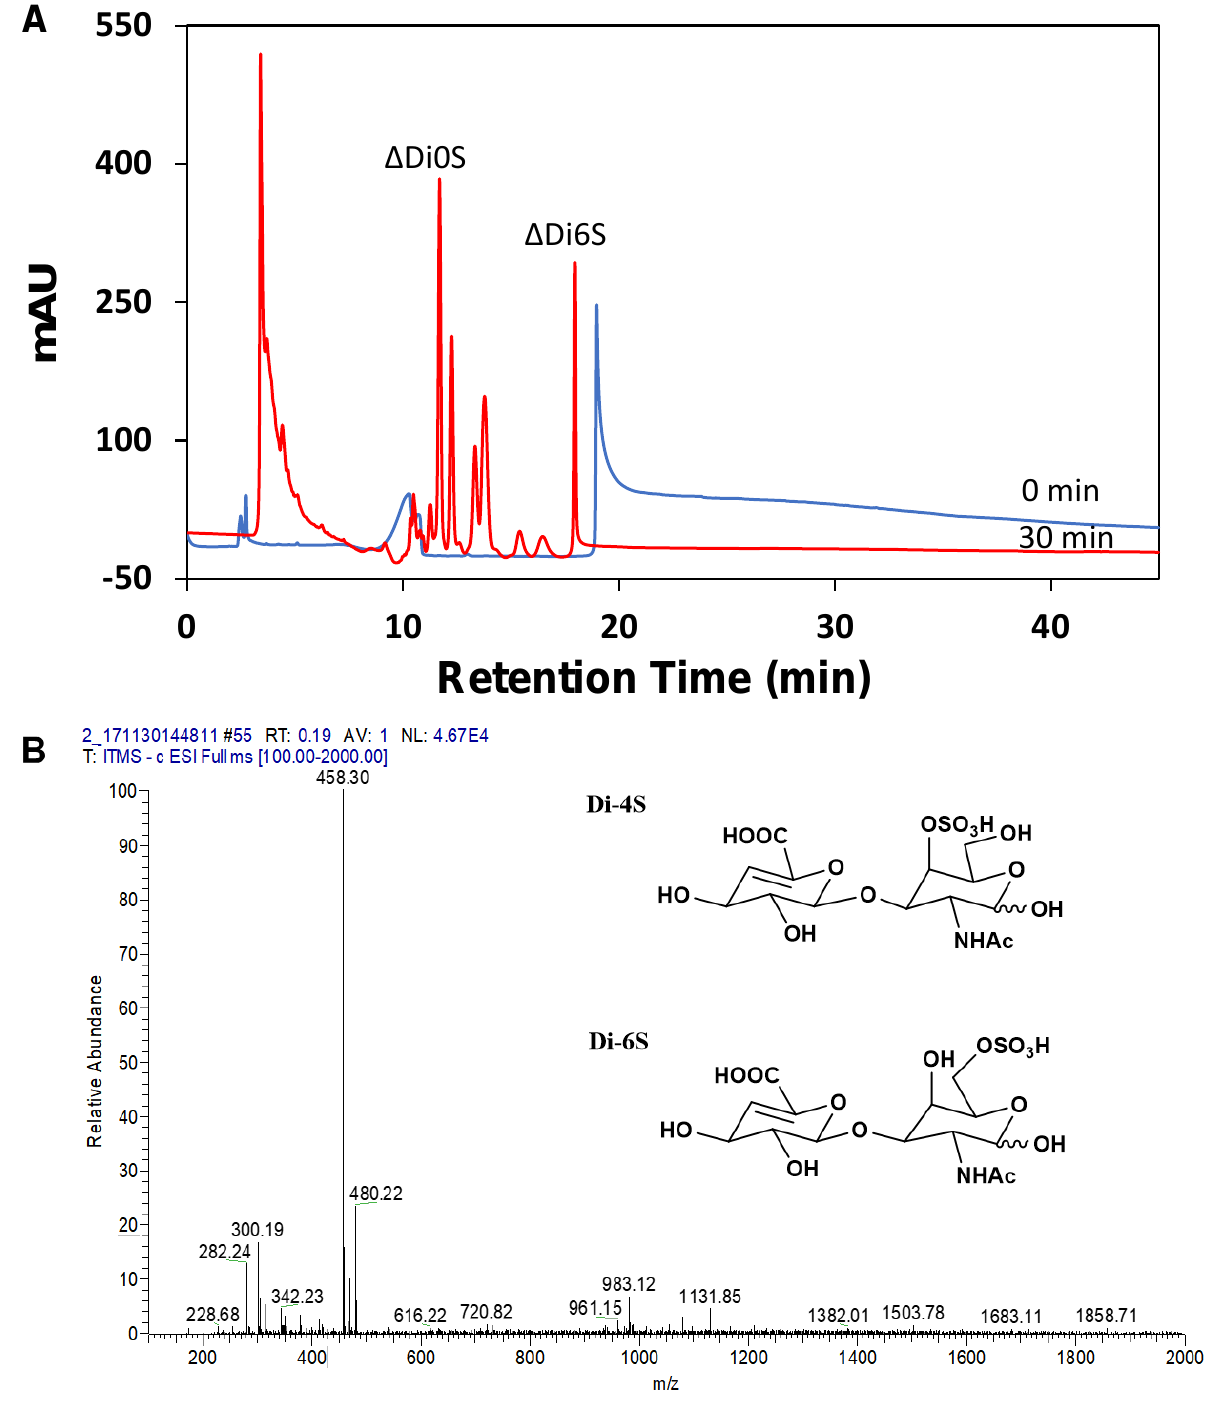
Figure 6. SAX-HPLC ( A ) and MS ( B ) analysis of the CS and hydrolyzed CS after 30 min enzymatic reaction . ΔDi0S = ΔUA - GalNAc; ΔDi6S = ΔUA -GalNAc6S.